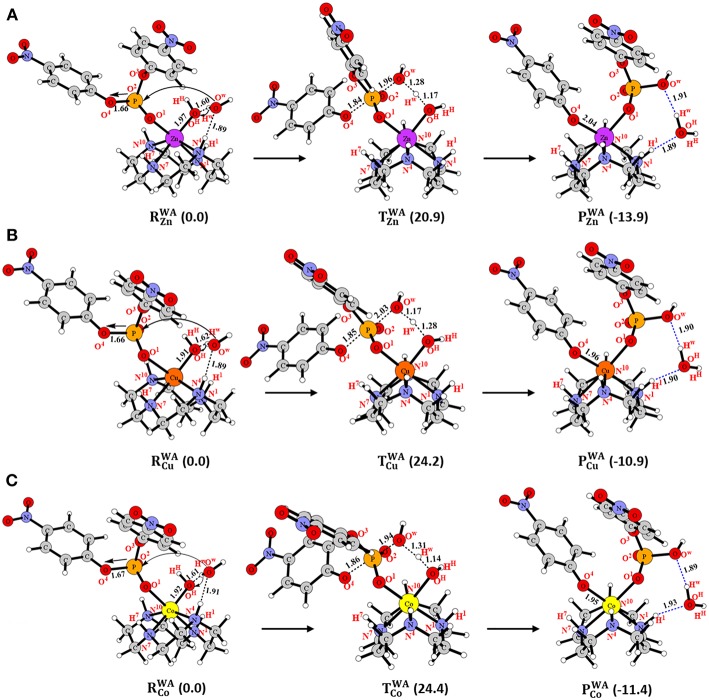
Structures (in Å) and energies (in kcal/mol) in the WAmechanism for (A) Zn-C, (B) Cu-C and (C) Co-C.